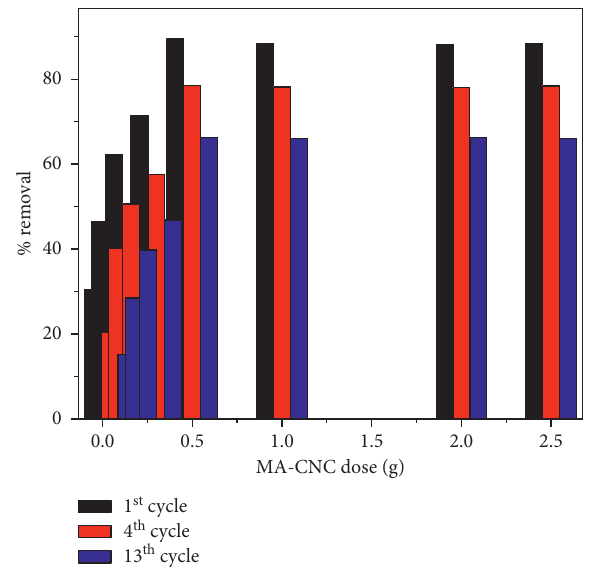
Figure 12: Percentage of Cd(II) ions’ removal after different cycles (1st, 4 th , and 13 th ) by MA-CNC